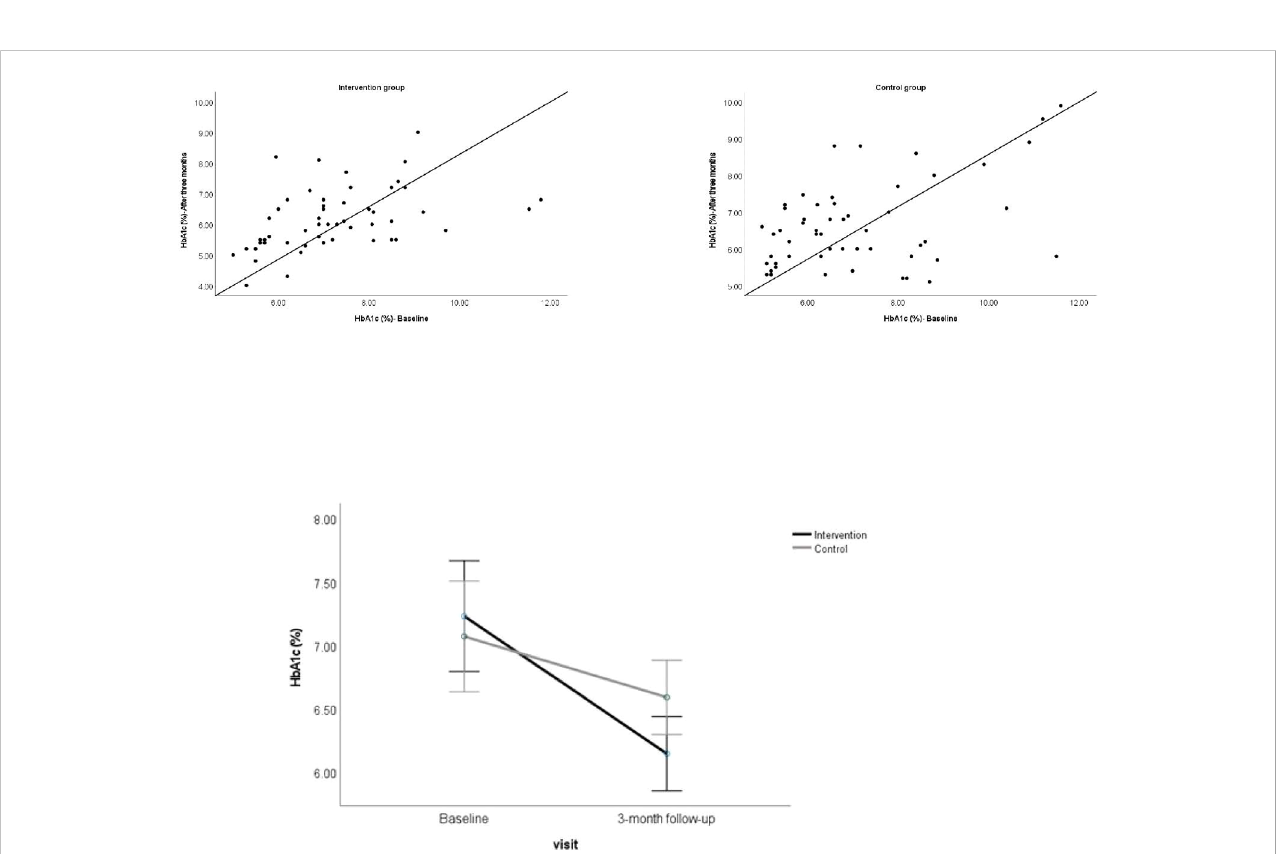
FIGURE 1 Above. Scatterplot showing the HbA1c for individual participants at baseline against 3-month follow-up visit. Below. Showing the mean HbA1c for the participant groups at baseline and 3-month follow-up visit. Error bars represent 95%